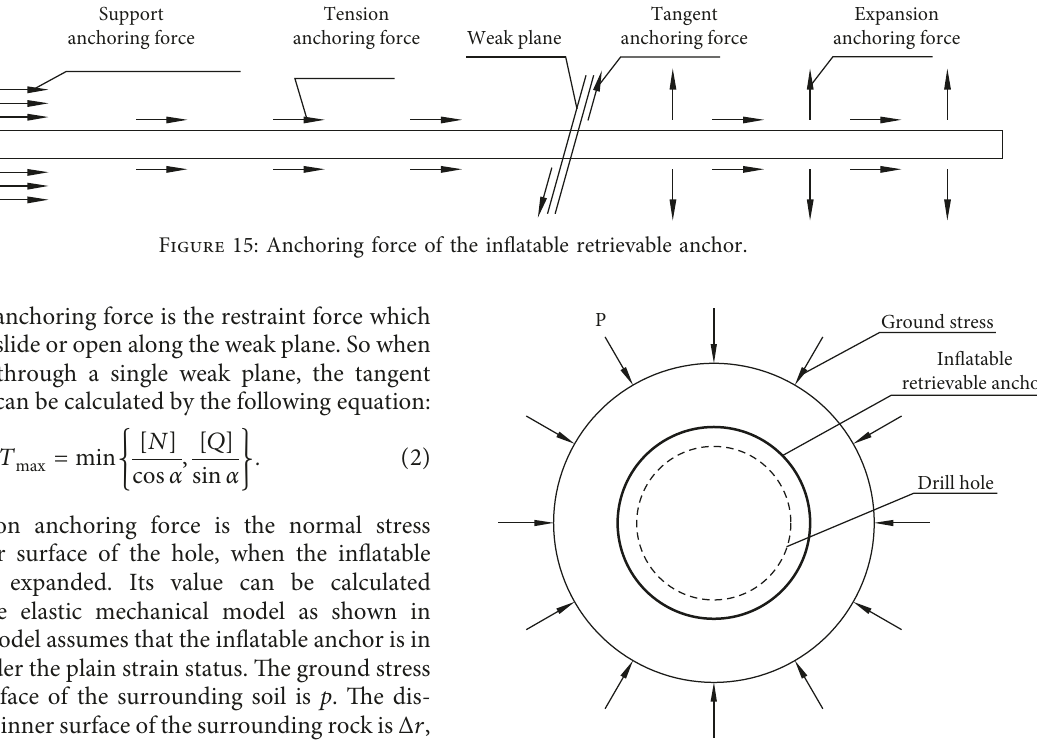
Figure 16: Mechanical model of the inflatable retrievable